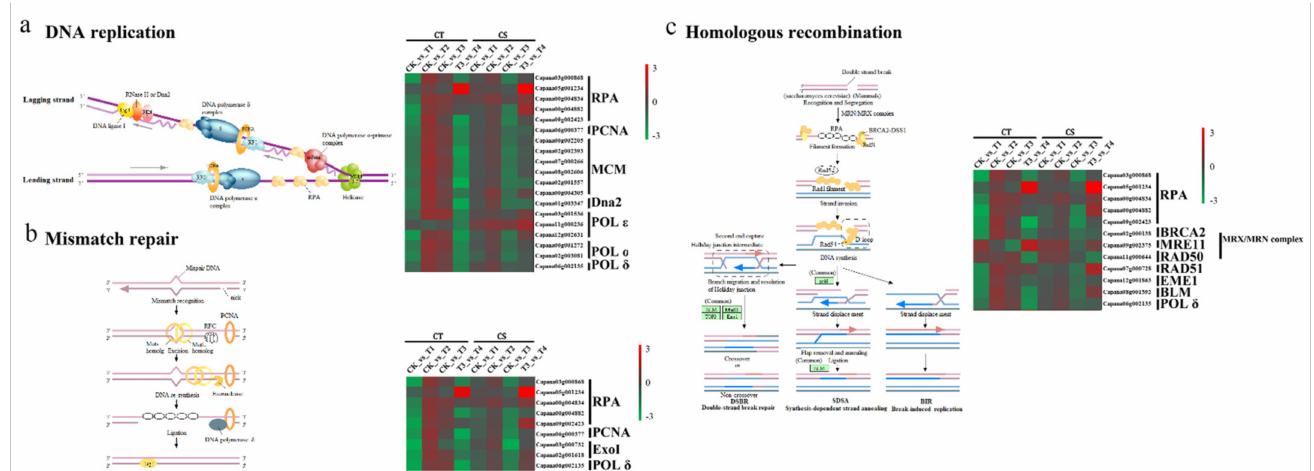
Figure 6. DEGs involved in DNA damage response. ( a ) DEGs shared in DNA replication and comparison of their expression patterns in CT and CS. ( b ) DEGs shared in Mismatch repair (MMR) and comparison of their expression patterns in two cultivars. ( c ) DEGs shared in Homologous recombination (HR) and comparison of their expression patterns in CT and CS. The log2FC values were used for mapping. Red color represents high gene expressions; green color represents low gene expressions.